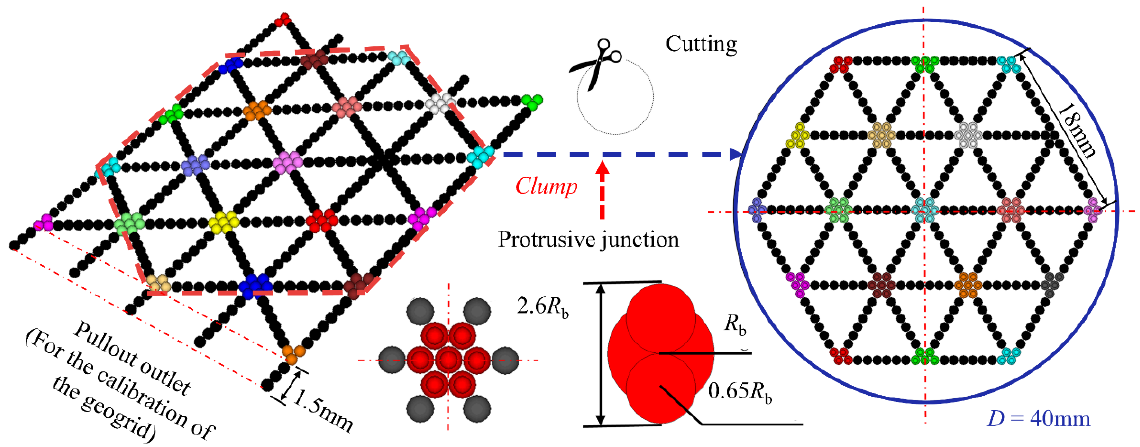
Figure 3. The triaxial geogrid particle flow model.